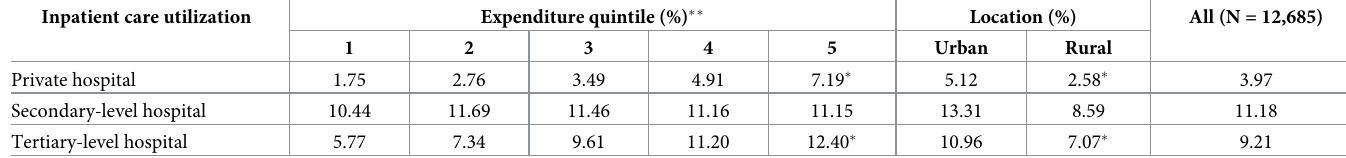
Table 1. Distributions of inpatient care utilization by expenditure quintiles and location in Mongolia, 2012 (%). Inpatient care